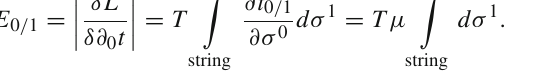
Fig. 25 The set of unstable elliptic string solutions in the moduli space